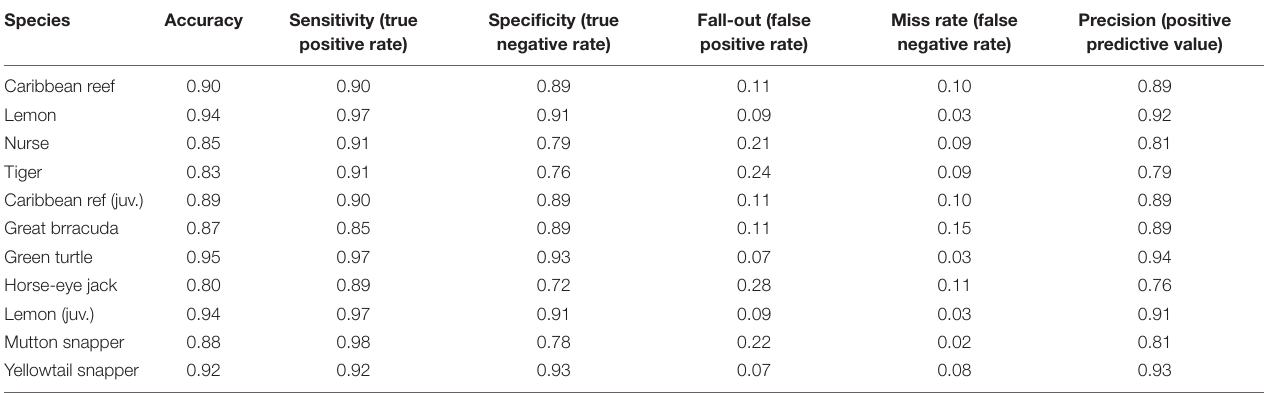
Specificity (true Fall-out (false Miss rate (false Precision (positive positive rate) negative rate) positive rate) negative rate) predictive value)